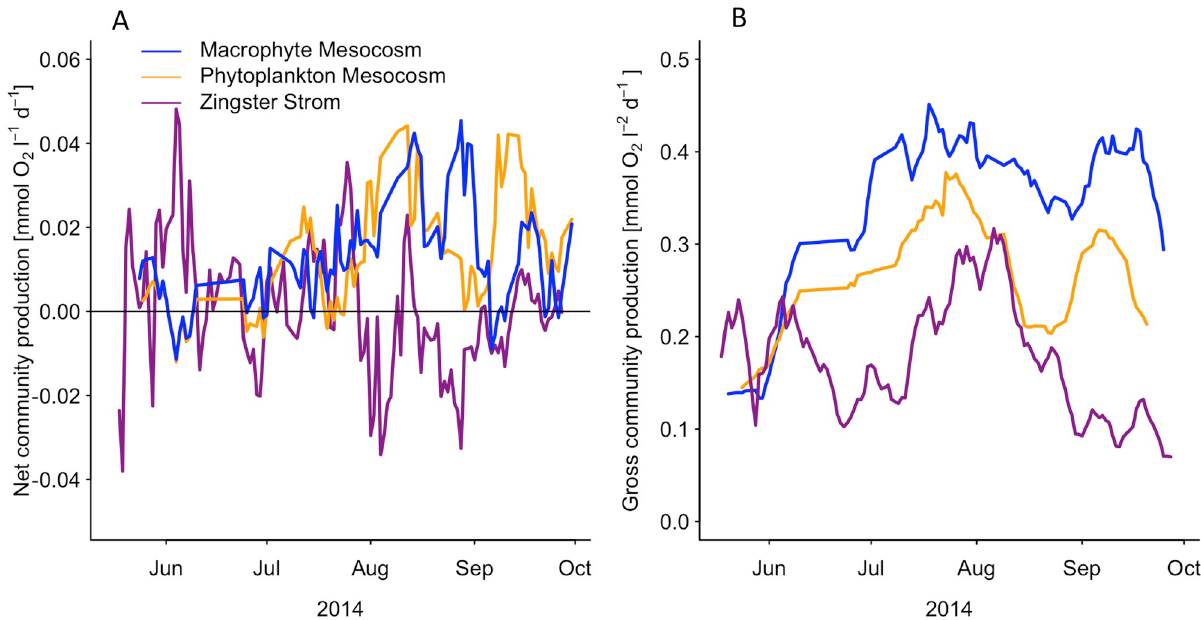
Fig 3. A–Surface net community production (mmol O 2 l -1 d -1 ), the sum of daytime production and night time respiration, in macrophyte mesocosms (blue), phytoplankton mesocosms (orange), and the Zingster Strom (magenta). Dates of cleaning and sampling including the following day were removed prior the analysis. Weekly running mean of daily values are shown. B–Surface daytime gross primary production, in macrophyte mesocosms (blue), phytoplankton mesocosms (orange) and the Zingster Strom (magenta), calculated as the integrated sum of net daytime production and a daytime respiration demand. Daytime respiration was calculated from the average night time respiration rate of the respective system and multiplied by the hours of daylight. Values represent only the production around the sensor at the respective